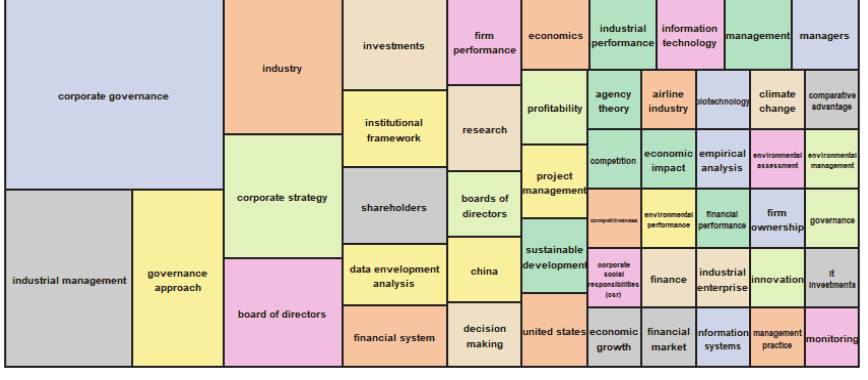
Fig. 5. The word Tree